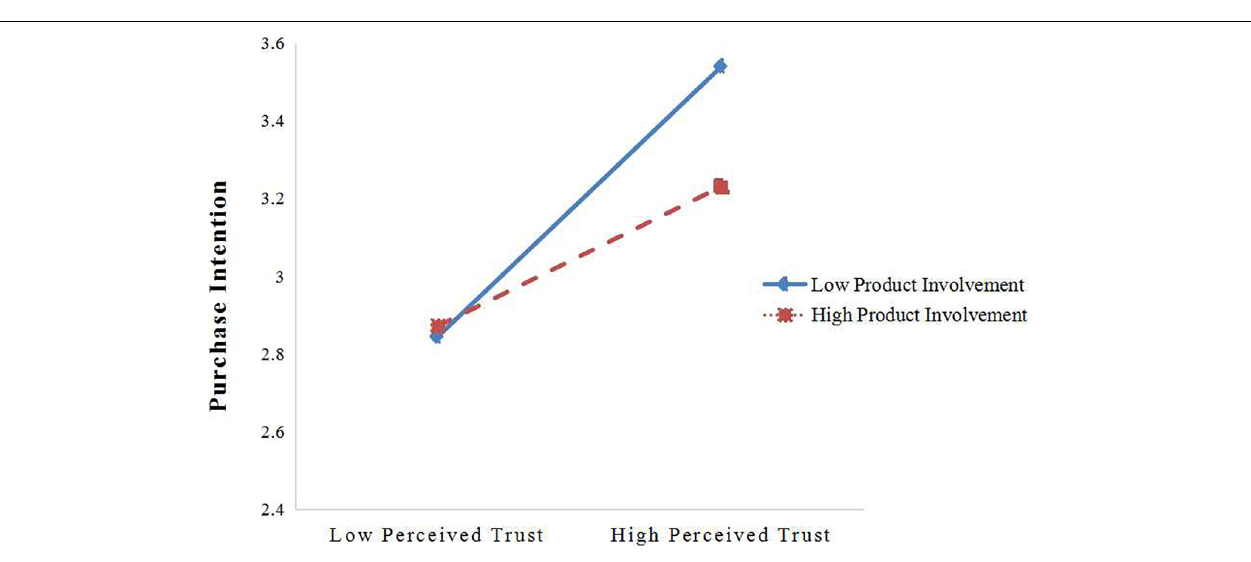
FIGURE 4 | Interaction of perceived trust and product involvement on purchase